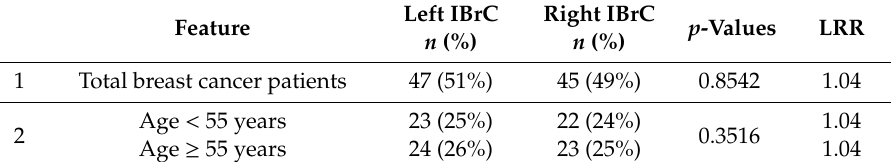
Table 1. Clinical presentation of patients according to breast cancer